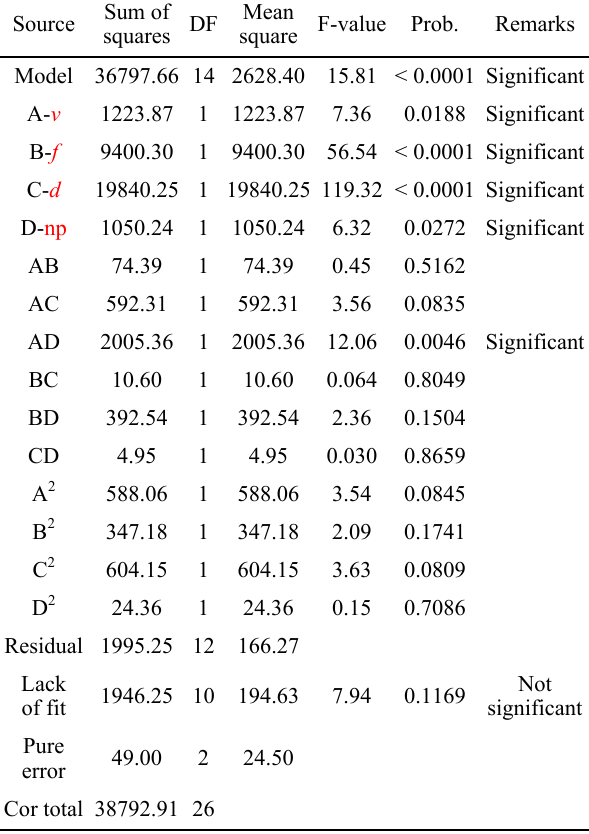
Table 5 ANOVA table of nodal temperature ( T ) for Al-MWCNT hybrid